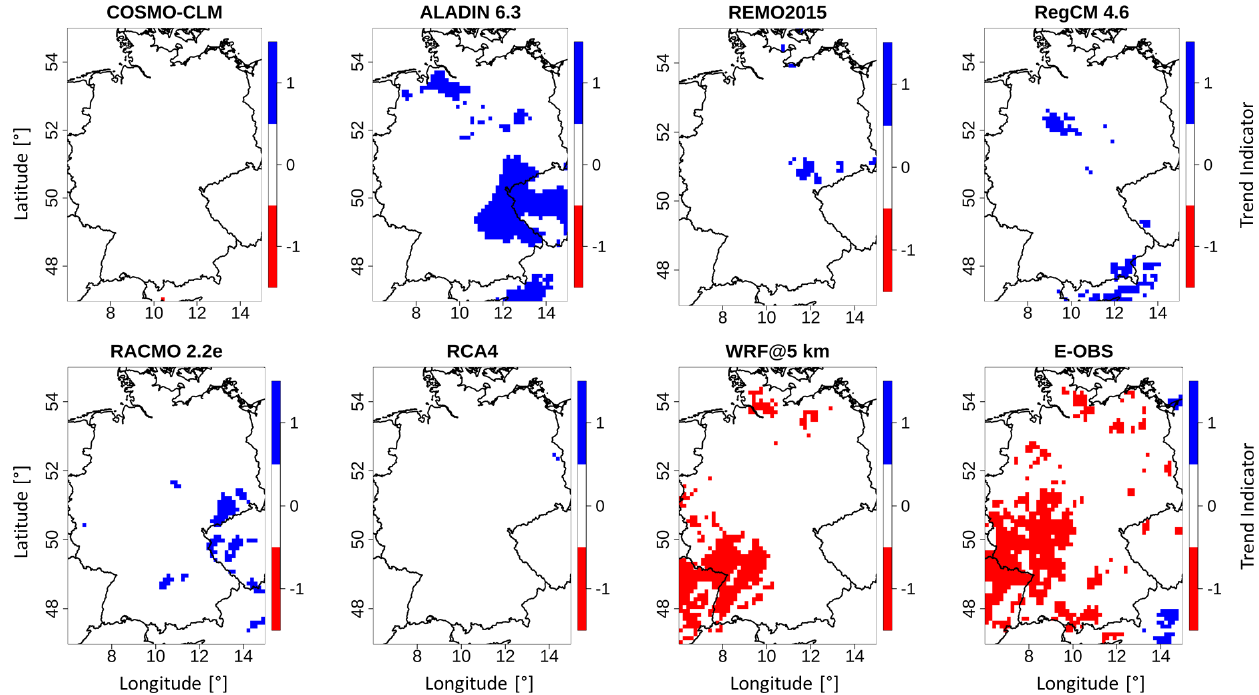
Figure 4. Grid-cell-based SPEI-3 trends for 1980–2009 based on the Mann–Kendall test for each RCM and E-OBS.